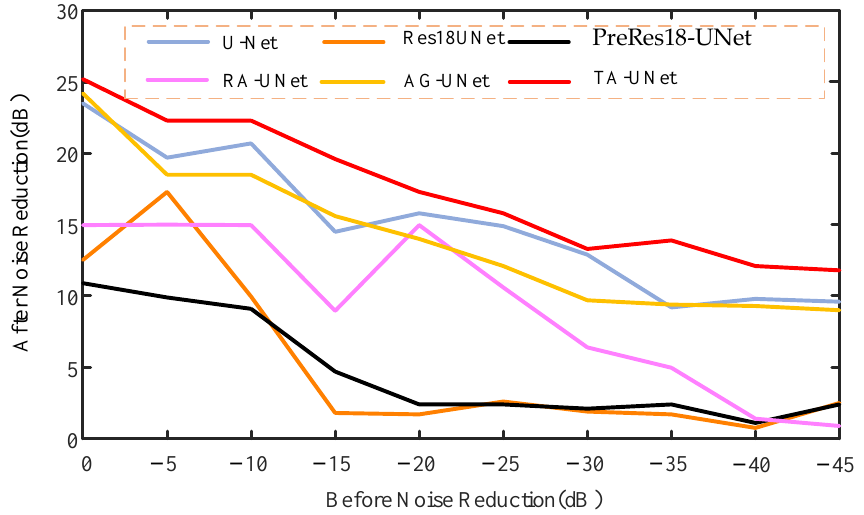
Figure 7. Noise reduction results of different networks for different SNRs.